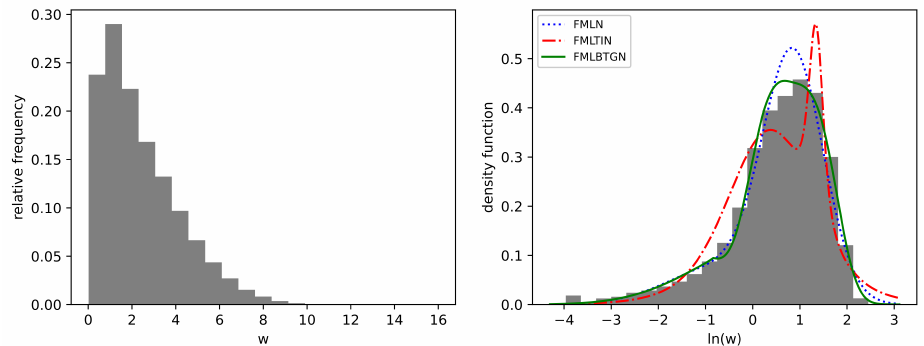
Figure 10. Histogram of hourly wind speed measurements and fitted finite mixture density functions. Table 5. Fitted two-component mixture distributions, in-sample criterion, and cross-validated LL. AIC